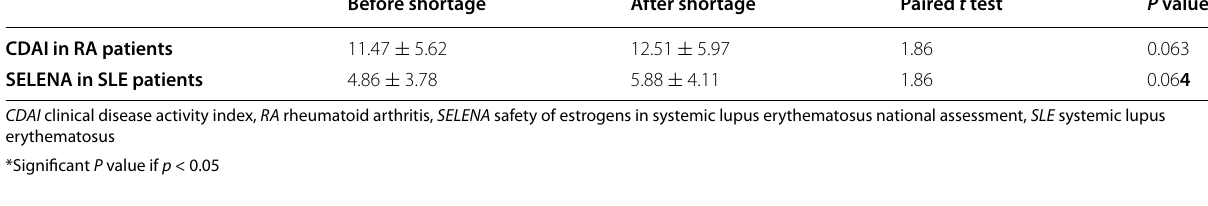
Table 2 Disease activity before and after HCQ shortage